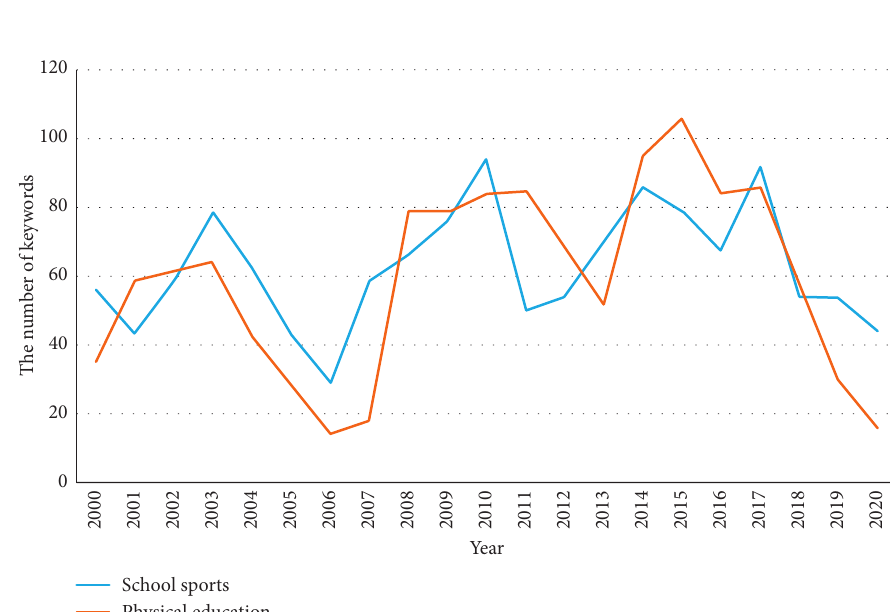
Figure 6: The trend of keyword, school sports and physical education.